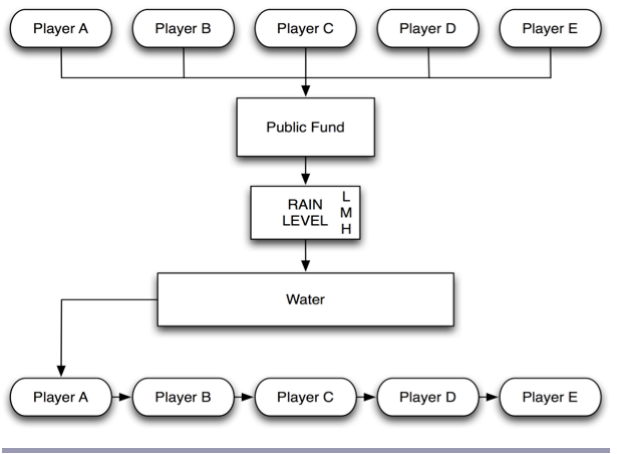
Fig. 1 . Flow chart of one irrigation experiment round.